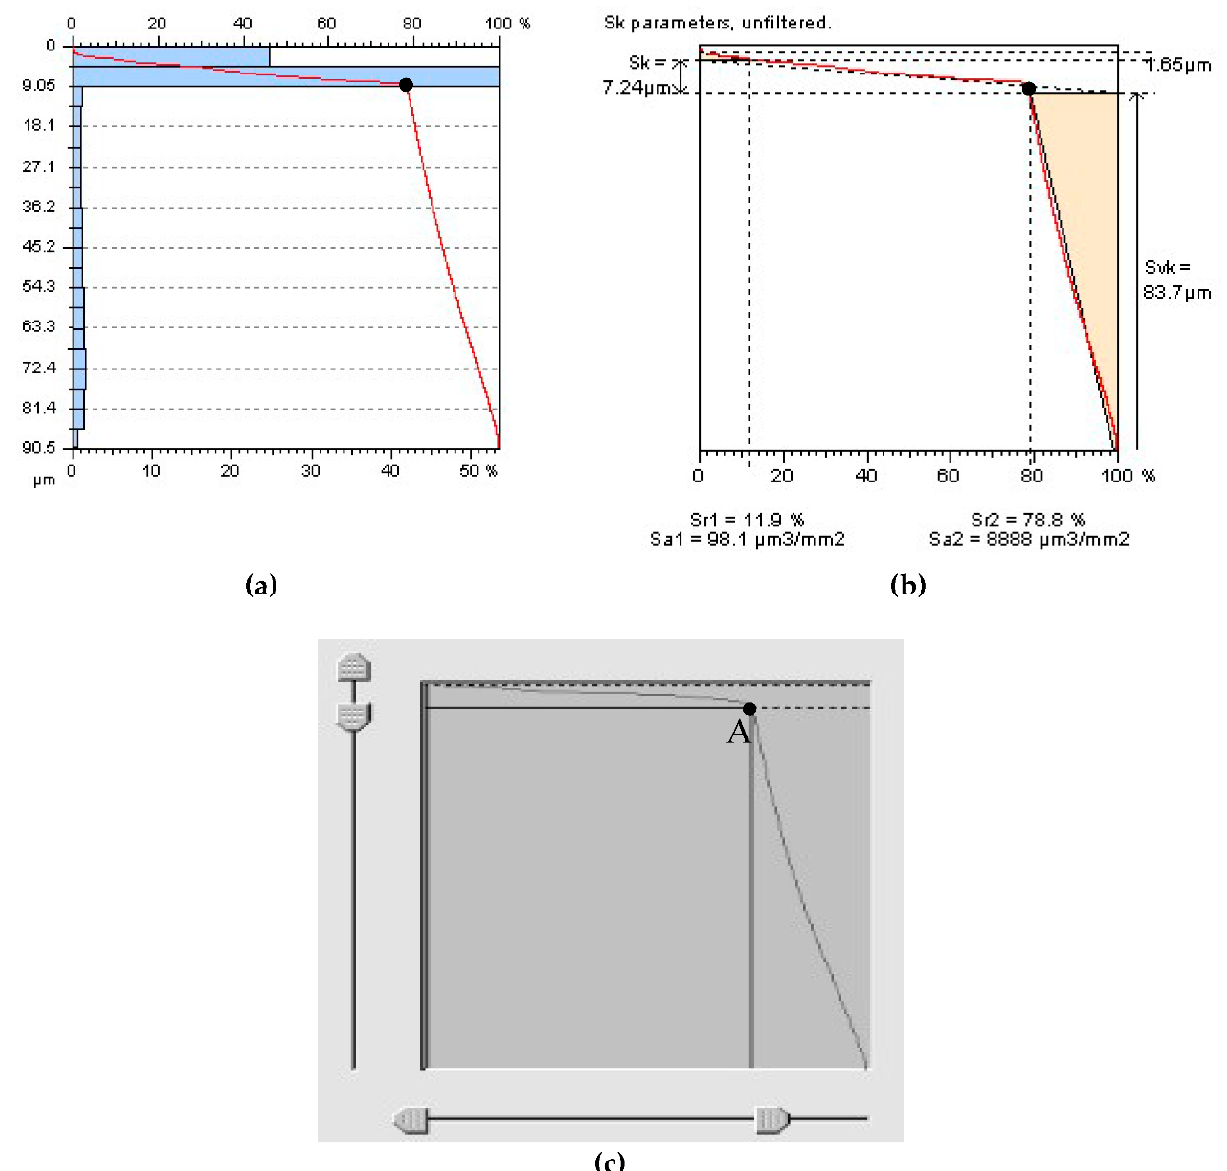
Figure 5. Method of selection of the thresholding value A ( c ) with the Abbott-Firestone curve ( a ) (material ratio curve ( b )) for plateau-honed cylinder liner surface containing dimples, the approach is based on the Sk and Svk parameter descrip- tions.